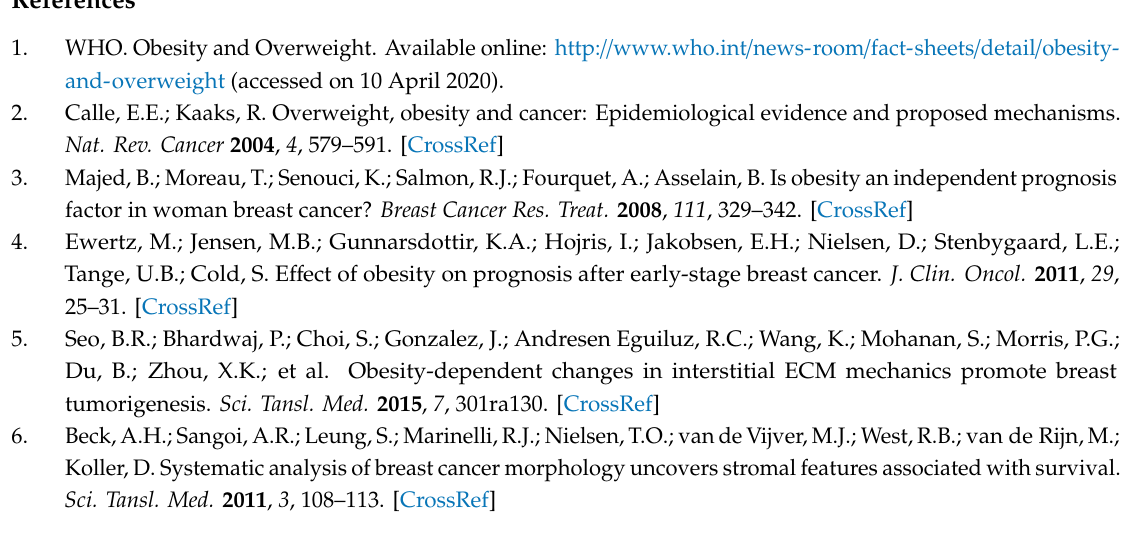
Figure S1: Similar expression of oncogenes and luminal / basal epithelial cell markers in SVF / EV and SVF / CCL2 tumors from mice, Figure S2: Characterization and flow cytometry gating strategy of transplanted mammary glands, Figure S3: Gating strategy for flow cytometry of bone marrow, Figure S4: Depletion of CD11b + cells following DT treatment and end-stage tumors in Mac / SCID mice, Figure S5: CCR2 and CD11b-expressing cells in CAF